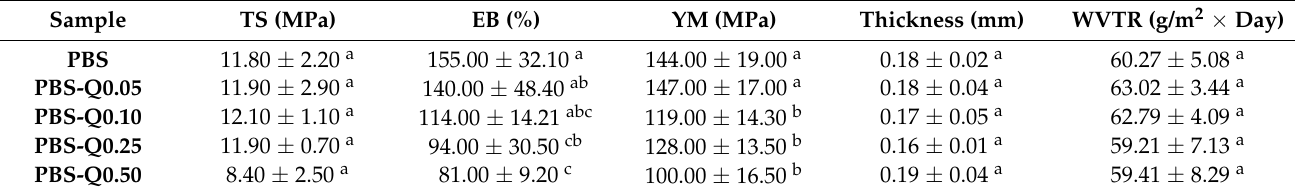
Table 3. Tensile strength (TS), elongation at break (EB), Young’s modulus (YM), thickness and water vapor transmission rate (WVTR) of PBS-based